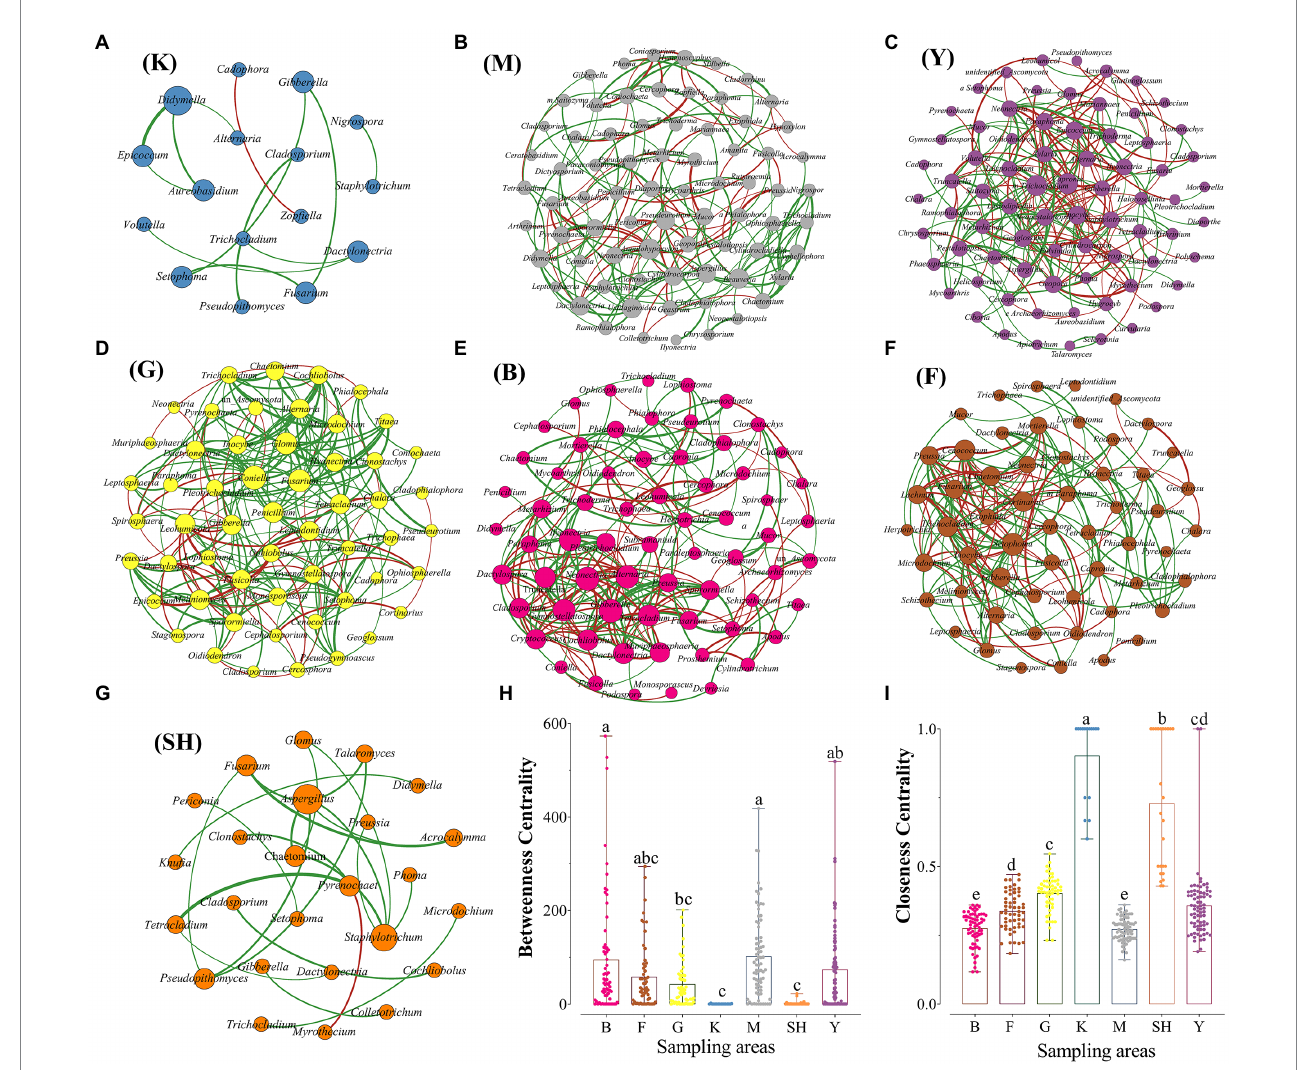
FIGURE 6 The site-specific co-occurrence network maps of the fungal community at the genus level in ( A = K) Meishan to Ping Ke Xian; ( B = M) Meishan region; ( C = Y) Ya’an area; ( D = G) grasslands at SNFP; ( E = B) boundaries of forests and grasslands at SNFP; ( F = F) forests at SNPF; and ( G = SH) the Taihang Mountains. The values of betweenness centrality (H) and closeness centrality (I) were calculated as two main features of co-occurrence networks. Red links indicate negative interactions between the two individual nodes, whereas green links indicate positive